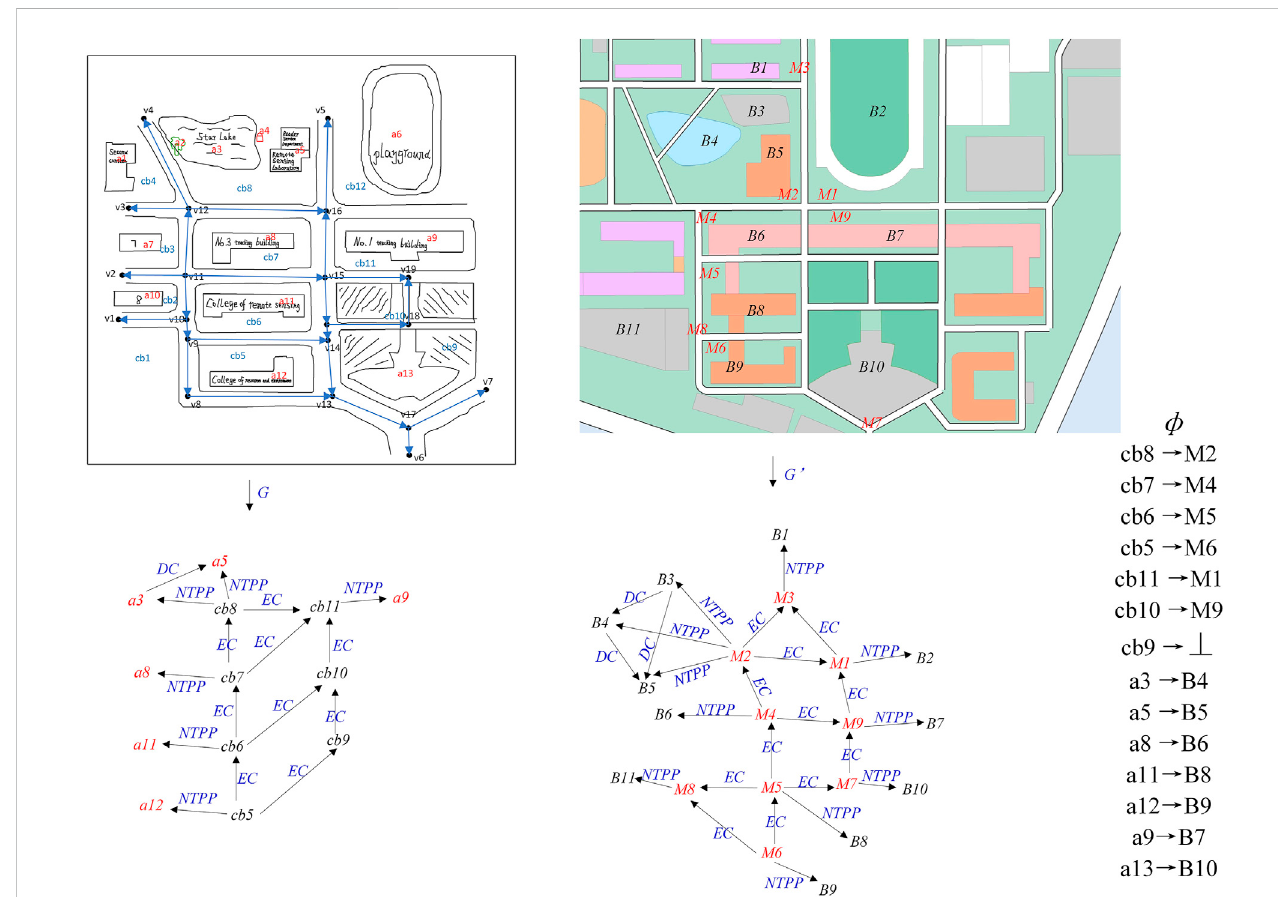
FIGURE 5 RCC8-based topological relationship both sketch map and vector maps near the south gate of the informatics department.